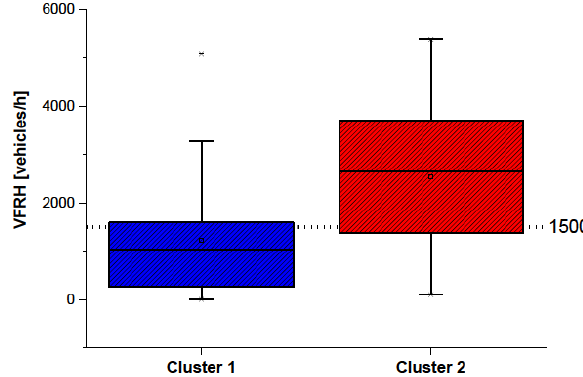
Figure 6: Box plots of the vehicle flow at rush hour (VFRH) for the two mean cluster profiles. Roads with traflc flow rate at rush hour < 1500 vehicles/hour can be associated with cluster 1; roads with traflc flow rate at rush hour > 1500 vehicles/hour to cluster